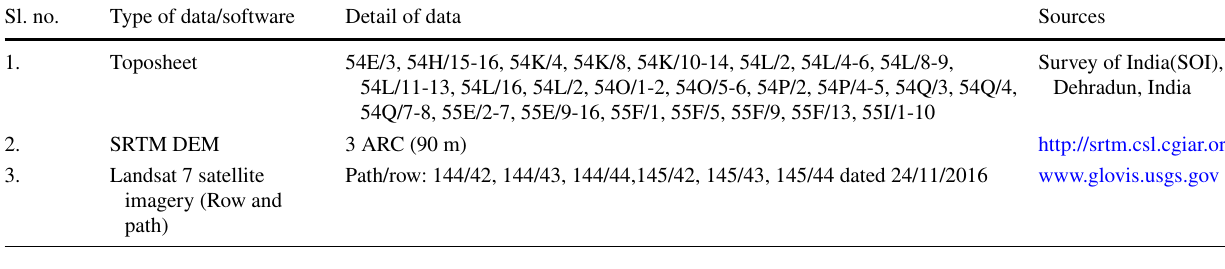
Fig. 2 Steps involved in